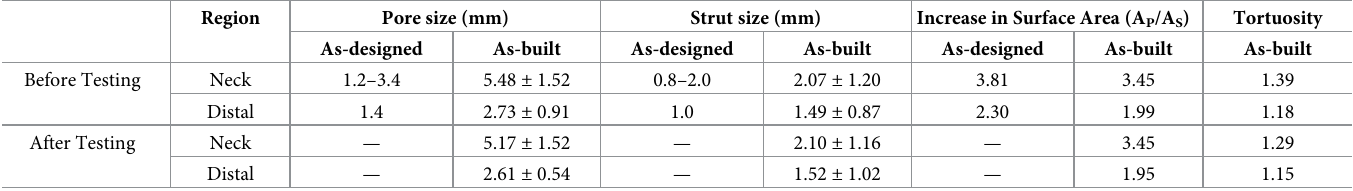
Table 1. Morphological parameters at the porous regions of the prosthesis. Region